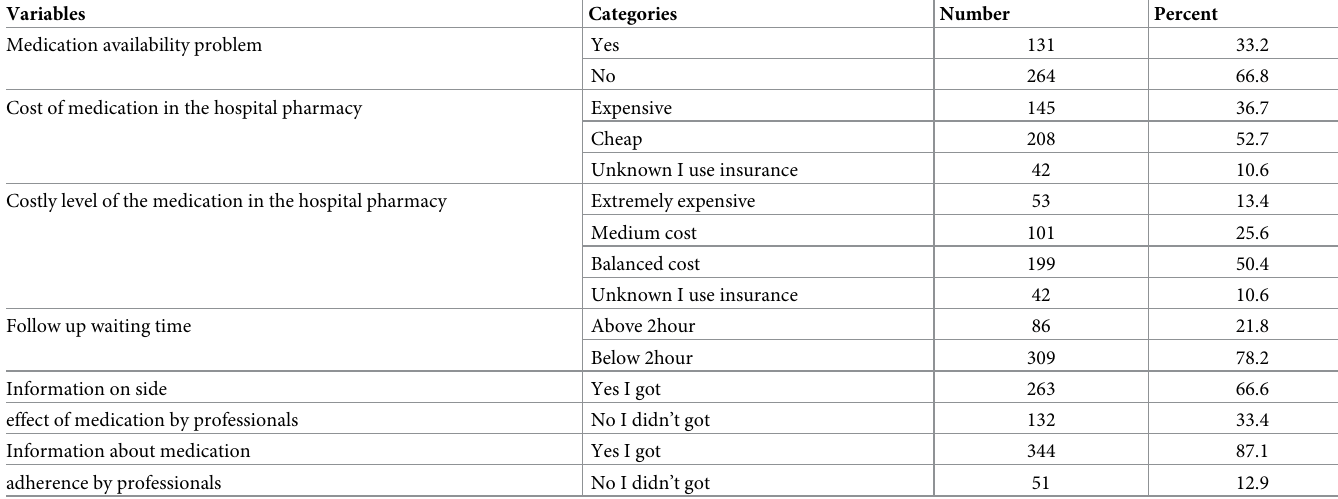
Table 3. Frequency distribution of respondents by health system related factors in Asella Referral and Teaching Hospital